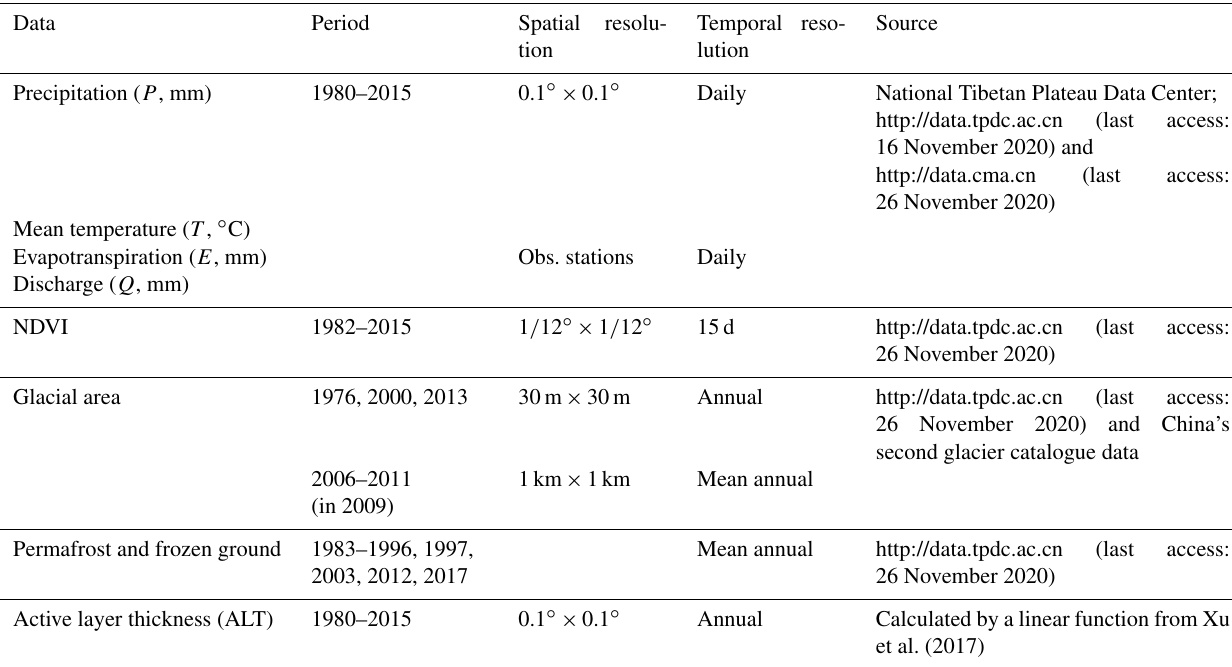
Table 1. Information of the data used in this study.